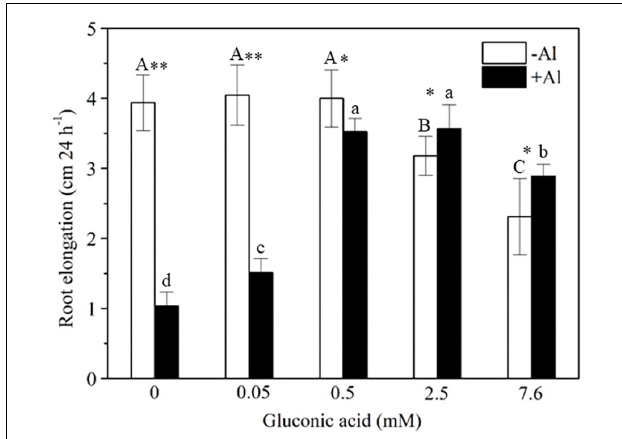
FIGURE 8 | Effect of gluconic acid on Al-induced inhibition of root elongation in rice. Two-day-old rice seedlings (cv. Kasalath) were exposed to a solution of 0.5 mM CaCl 2 (pH 4.5) containing 0, 0.05, 0.5, 2.5, or 7.6 mM gluconic acid in the absence (–Al) and presence (+Al) of 50 µ M Al for 24 h. Root length was measured with a ruler before and after treatment. Vertical bars represent standard deviations of the means ( n = 10). Different capital and lowercase letters above columns indicate significant differences ( p < 0.05) among different concentrations of gluconic acid under –Al and + Al, respectively. Asterisks above columns indicate significant differences ( ∗ p < 0.05; ∗∗ p < 0.01) between –Al and